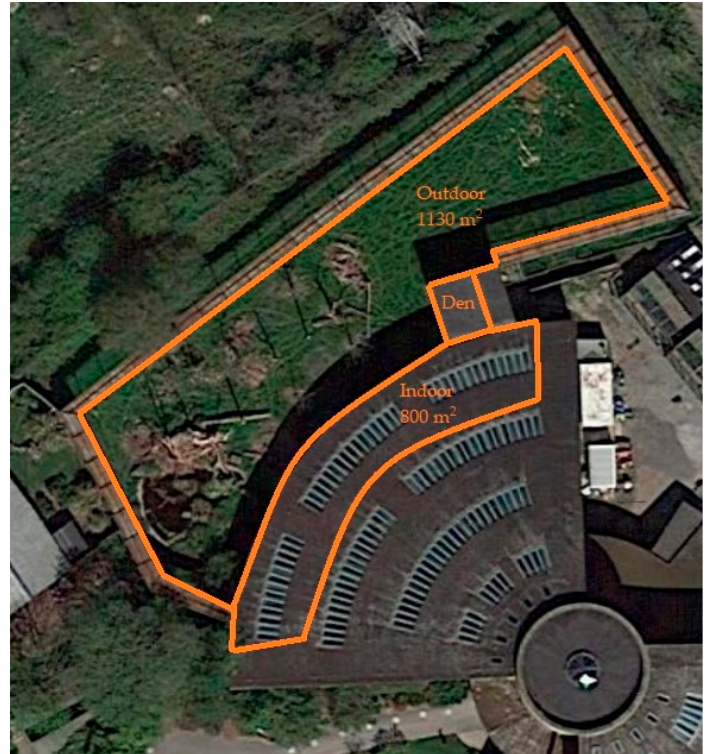
Figure A5. Enclosure plan for Malayan sun bear ( Helarctos malayanus ) in the Spirit of the Jaguar exhibit.Orange lines signify approximate areas accessed by individual animals with dimensions of total available space. Copyright: Google Earth.